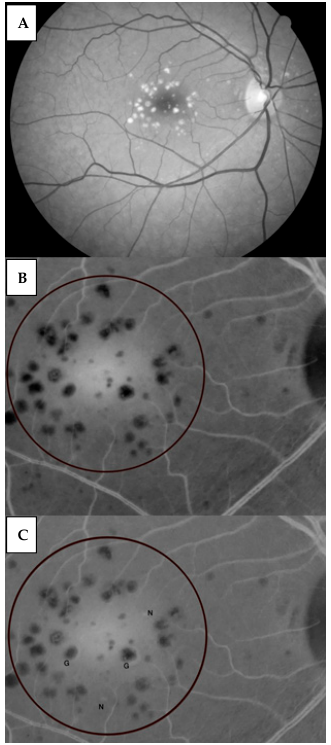
Figure 2. Red-free fundus snap-shot. ( A ) All the participants underwent an initial red-free fundus snap-shot. The number and volume of existing drusen were further assessed by subsequent red-free fundus imaging (Top). ( B ) A circle of an area of 1.5 optic discs around the macula was drawn, and the whole picture was transformed into a negative image (Middle). ( C ) Super-position of the final snap-shot (positive) on the initial snap-shot (negative). Drusen with a white halo are drusen of increased size (marked G). New drusen are represented by a white spot (marked N).